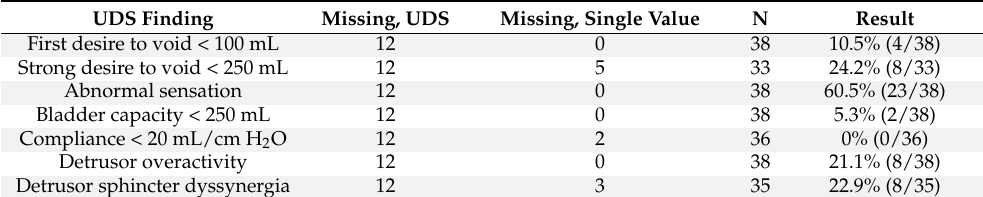
Table 3. Urodynamic results indicative of NLUTD. UDS Finding Missing,